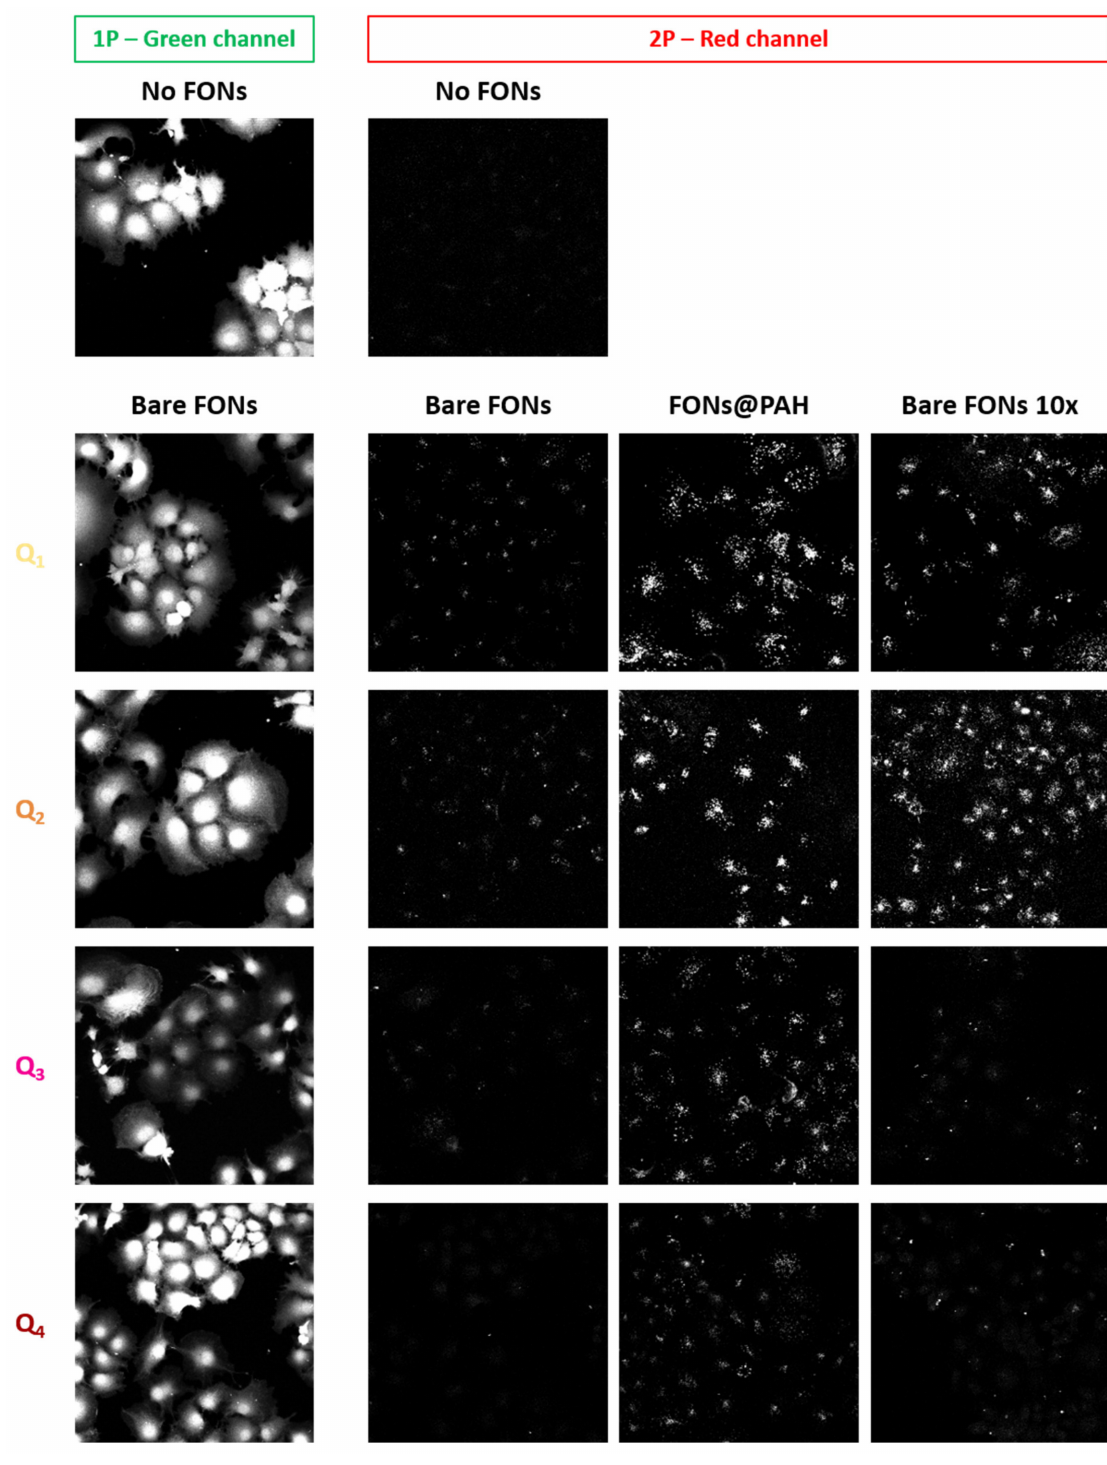
Figure 9. Imaging FONs in a cellular context. (Left column) Green channel collecting Calcein Green-AM fluorescence under 1P excitation; (Other three columns) Red-channel collecting FONs emission under 2P excitation, of which ( Left ) Bare FONs, ( Middle ) FONs coated with PAH and ( Right ) Bare FONs 10 times more concentrated during the incubation phase. Top two images were acquired on control cells not incubated with FONs (same illumination settings as for Q 2 imaging—see experimental details). Images represent the maximal projection of z-stack planes sectioning through the cells’